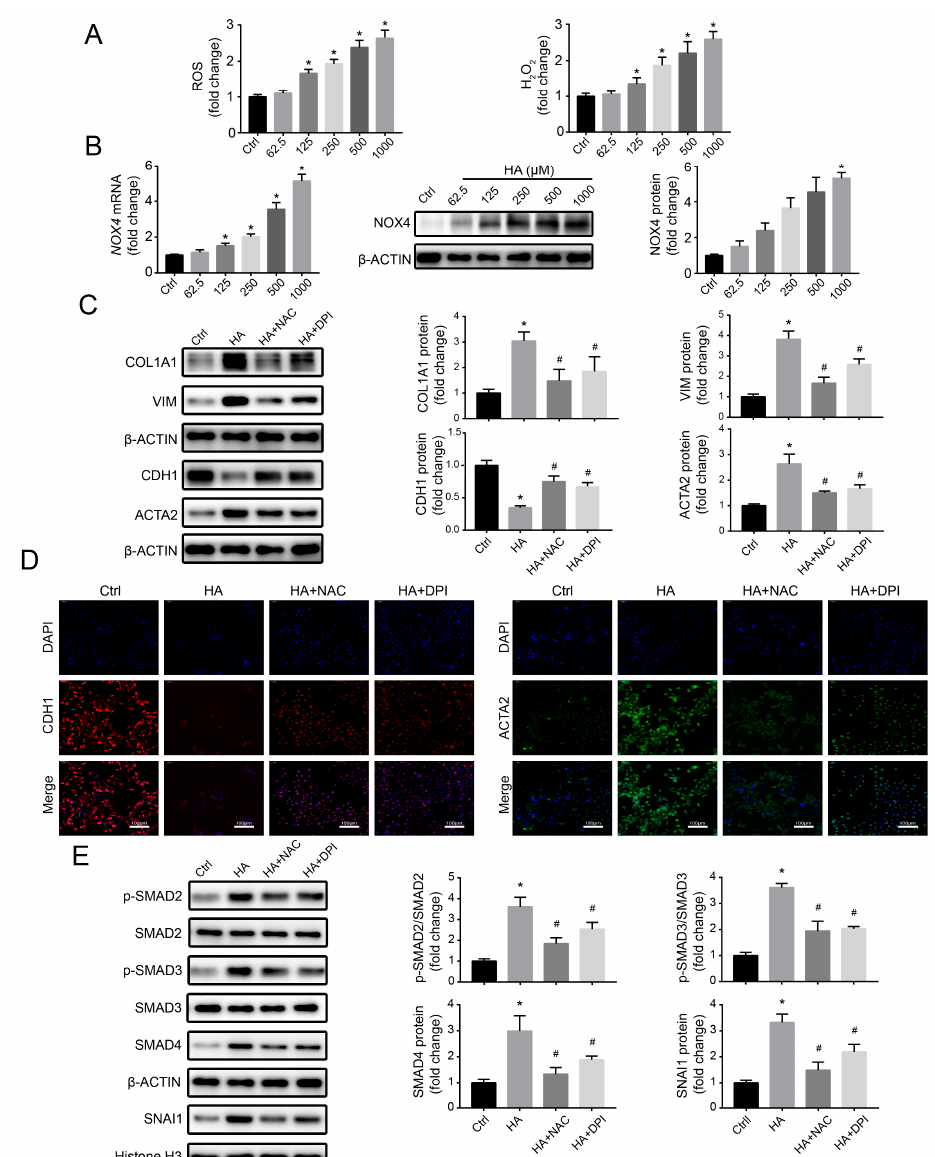
Figure 3. Role of oxidative stress in hippuric acid (HA)-induced fibrotic gene expression in HK-2 cells. ( A ) Levels of reactive oxygen species (ROS) and hydrogen peroxide (H 2 O 2 ) after treatment with 0–1000 µM HA. ( B ) Relative mRNA and protein expression levels of NADPH oxidase 4 (NOX4) after treatment with 0–1000 µM HA. ( C ) Levels of protein expression of collagen-I (COL1A1), vimentin (VIM), E-cadherin (CDH1), and alpha-smooth muscle actin (ACTA2) in cells pretreated with 1000 µM N -acetylcysteine (NAC), 50 µM diphenylene iodonium (DPI), or the vehicle, followed by treatment with 1000 µM HA. ( D ) Immunofluorescence staining for CDH1 (red) and ACTA2 (green) after pretreatment with 1000 µM NAC, 50 µM DPI, or the vehicle, followed by treatment with 1000 µM HA. Nuclei (blue) were stained with DAPI. Bar = 100 µm. ( E ) Expression levels of key proteins in the TGF β /SMAD signaling pathway in cells pretreated with 1000 µM NAC, 50 µM DPI, or the vehicle, followed by treatment with 1000 µM HA. Quantification was performed by densitometry. Data are presented as the mean ± standard deviation. * p < 0.05 vs. control (Ctrl) cells; # p < 0.05 vs. cells treated with HA only. Experiments were repeated three to five times.